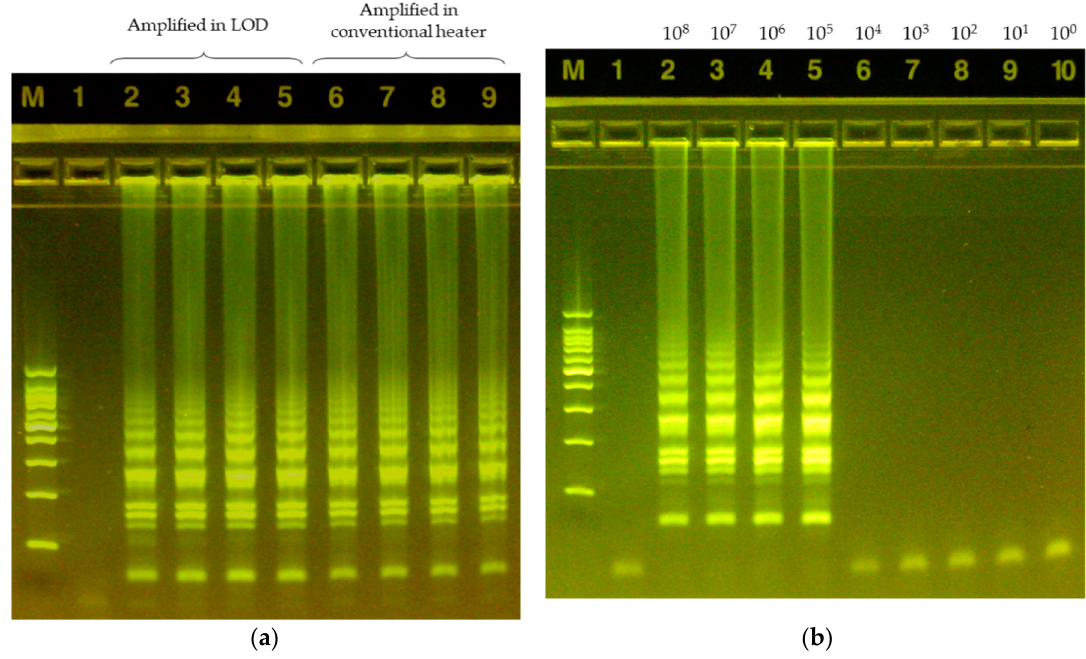
Figure 9. Electrophoresis result of experimental data. ( a ) M: DNA marker (24073, SizerTM-100bp DNA Marker, INtRON biotechnology, Seongnam Korea), 1st lane: Negative control (No Salmonella Typhimurium present in sample), 2–5th lane: LAMP product using LOD, 6–9th lane: Positive control (LAMP product using the heating incubator); ( b ) Electrophoresis result with 10-fold dilution (M: DNA marker, 1st lane: Negative control, 2nd–10th lane: LAMP product serially 10-fold diluted with the initial concentration of 10 8 CFU /